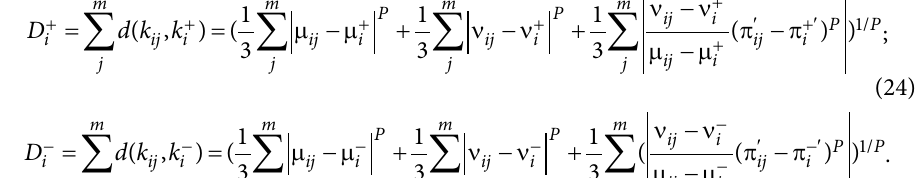
Table 17. Separation measures of each alternative A 1 A 2 A 3 A 4 + 0.0704 0.1500 0.2151 0.1710 i D − i D